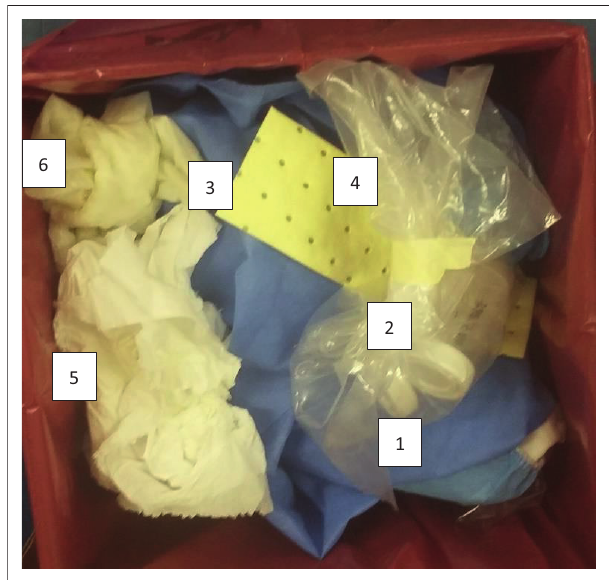
FIGURE 1: Open-lid image from a biological infectious waste disposal container in a reference tuberculosis laboratory at the end of a specimen processing shift in Cape Town, South Africa, 2022. 1, Disposable laboratory coat; 2, Appears to be a rejected specimen; 3, Sterile Cepheid Xpert® MTB/RIF Ultra packaging material; 4, Extensive plastic packaging from a tuberculosis specimen; 5, Large amount of absorbable cleaning paper; 6, Disposable latex